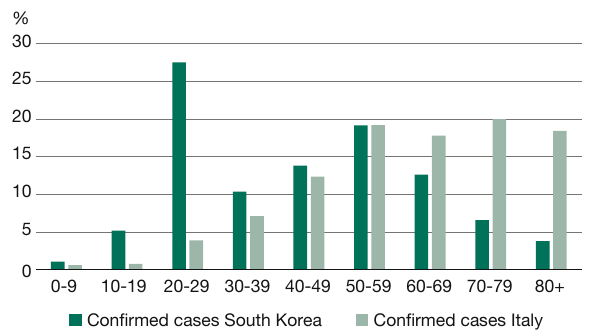
Figure 1 Share of confi rmed cases of infections with SARS- CoV-2 by age group in South Korea and Italy